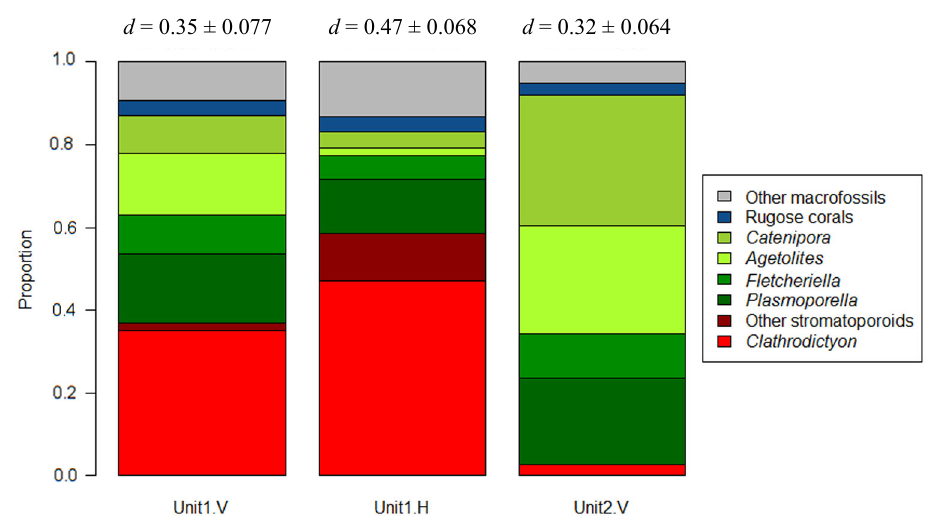
Fig. 4. Relative abundance of the macrofossils in the measured framework and the Berger(cid:150)Parker index for each community. Unit1.H, horizontal data from the first unit; Unit1.V, vertical data from the first unit; Unit2.V, vertical data from the second unit.